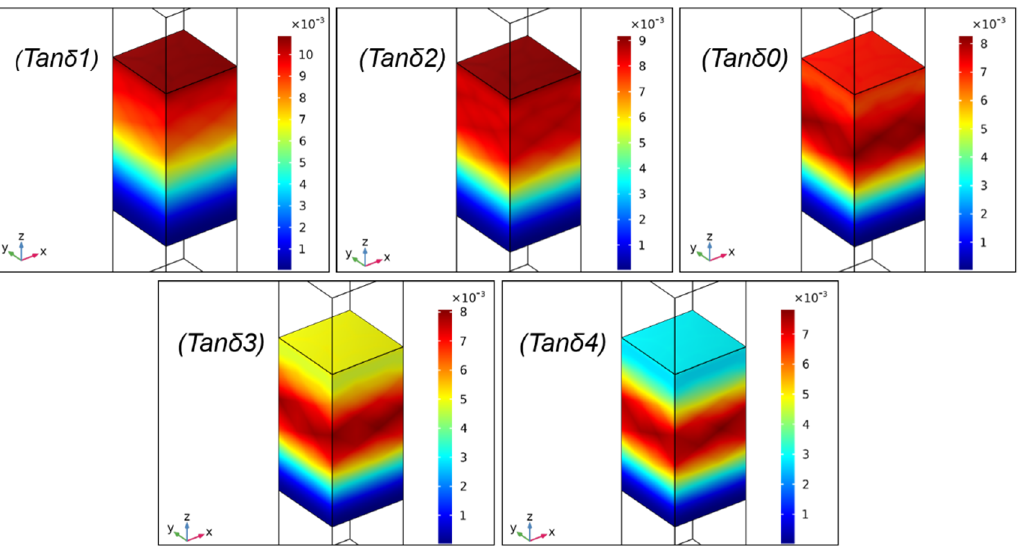
Figure 6. Total power dissipation density (mW/m 3 ) of the composite with different tan δ at 7 kHz.